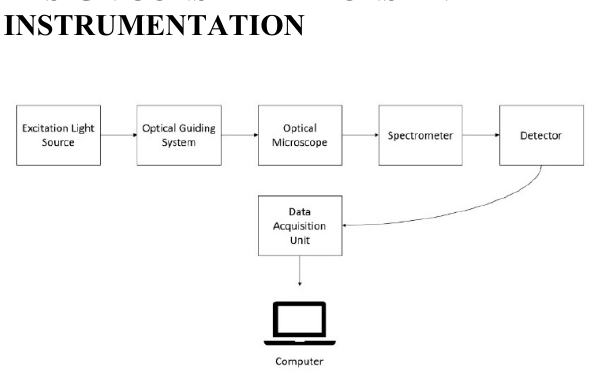
Fig. 1: Instrumentation of a typical dispersive Raman